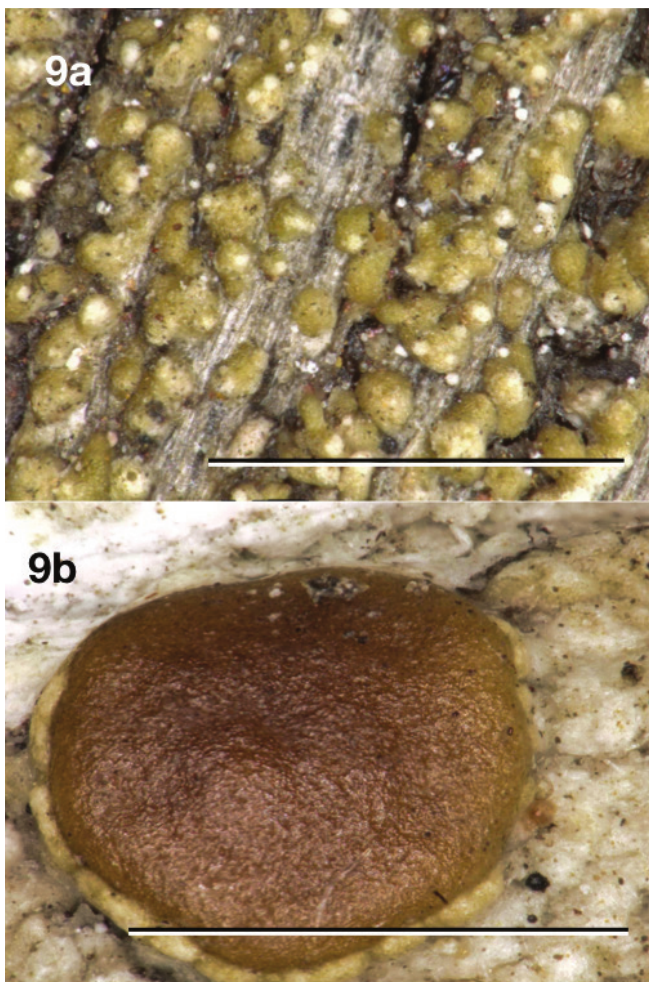
Figure 9. Neoprotoparmelia crassa Elix39818. Scale bar: 1